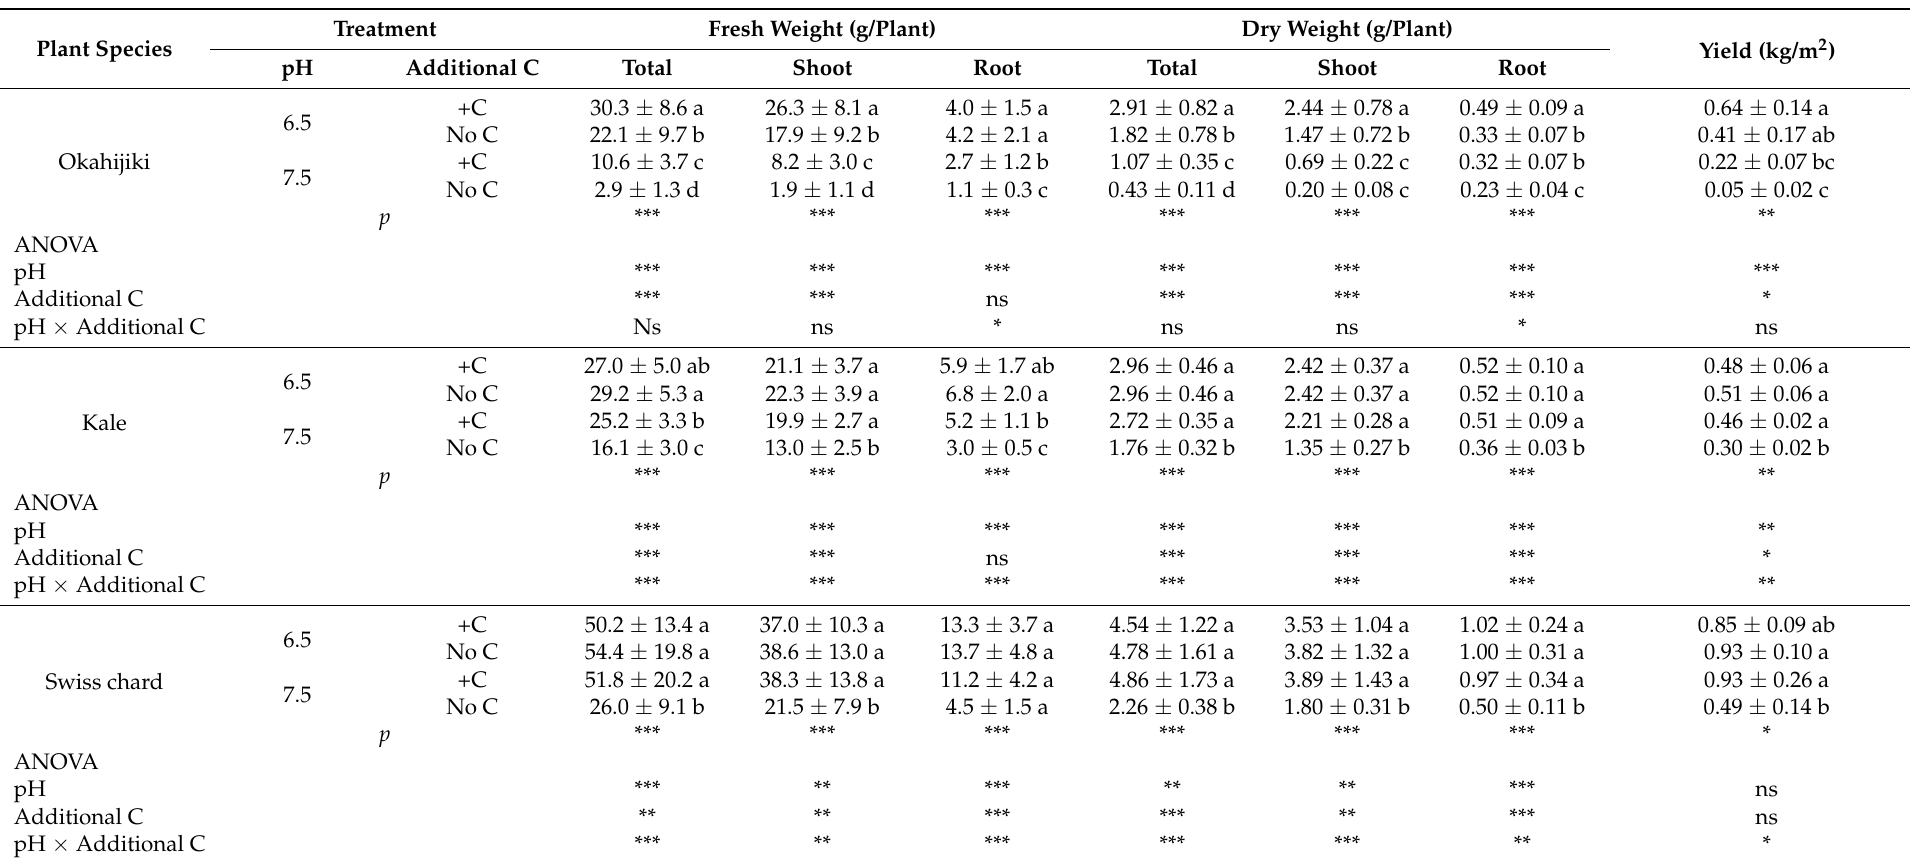
Table 3. Fresh and dry weight of okahijiki, kale, and Swiss chard in aquaponics under two pH levels with or without additional C in the second